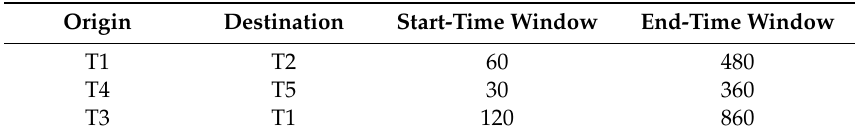
Table 1. Example of transport order data.